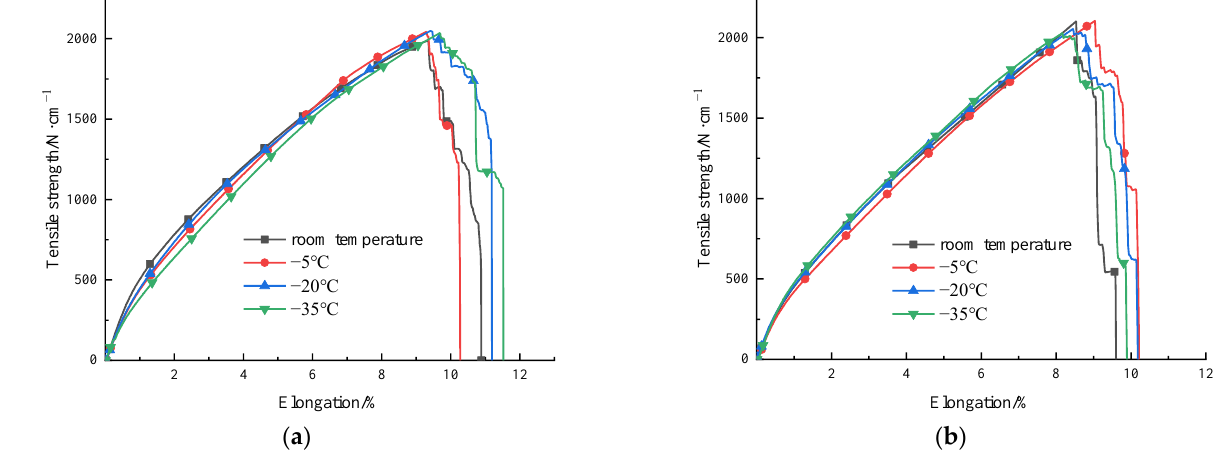
Figure 8 . Tension curves of PP specimens I ( a ) and II ( b ) respectively at different temperatures.